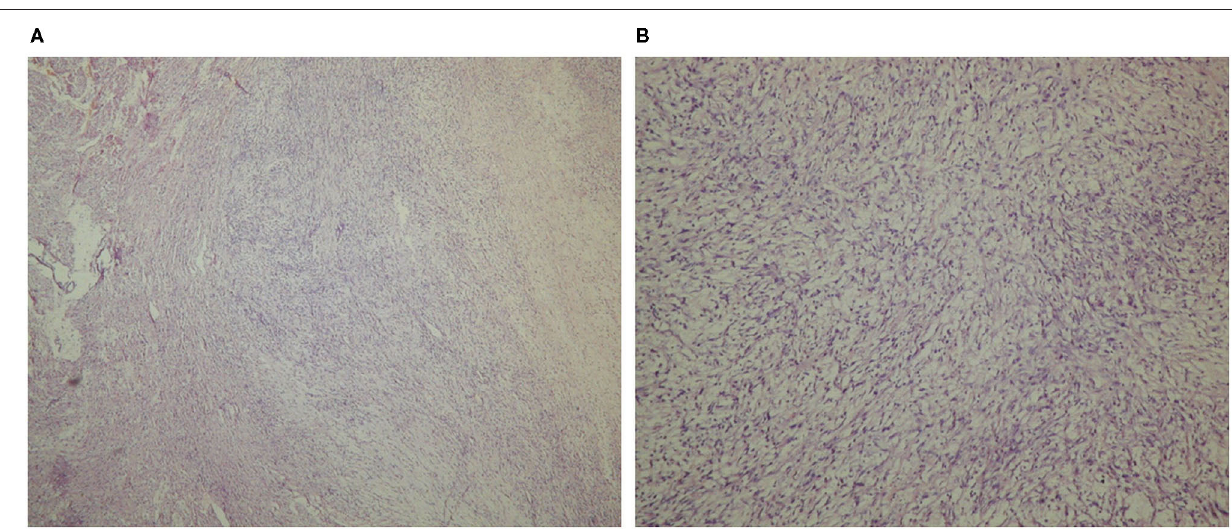
FIGURE 3 | Histologic specimen acquired from the tumor mass, light microscopic examination (Hematoxylin-Eosin stain), 40 × magnification (A) , and 100 × magnification (B)